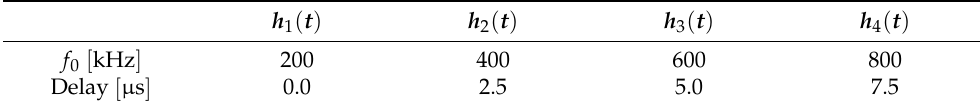
Figure 4. Kernels h i ( t ) adopted in the synthetic Hammerstein model of the fourth order. Plots ( A – D ): reference functions h 1 ( t ) , h 2 ( t ) , h 3 ( t ) , h 4 ( t ) , respectively. Table 1. Values that characterize the four kernels of the synthetic